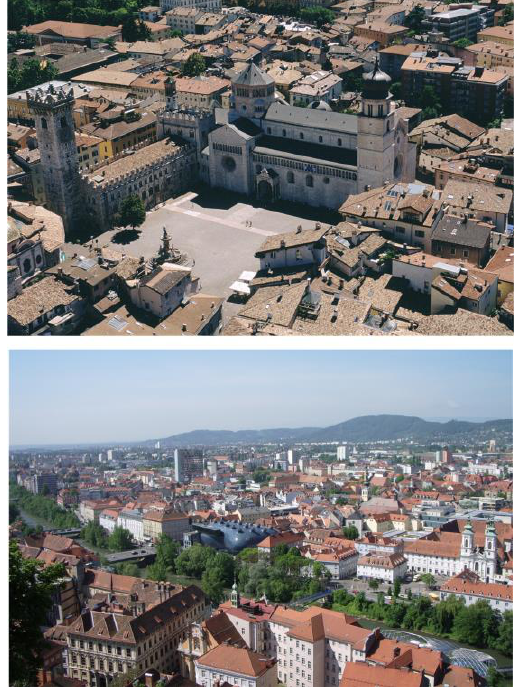
Figure 1. View of the project areas: Trento (top, source: www.discovertrento.it/), Graz (bottom, source: www.wikimedia.org).